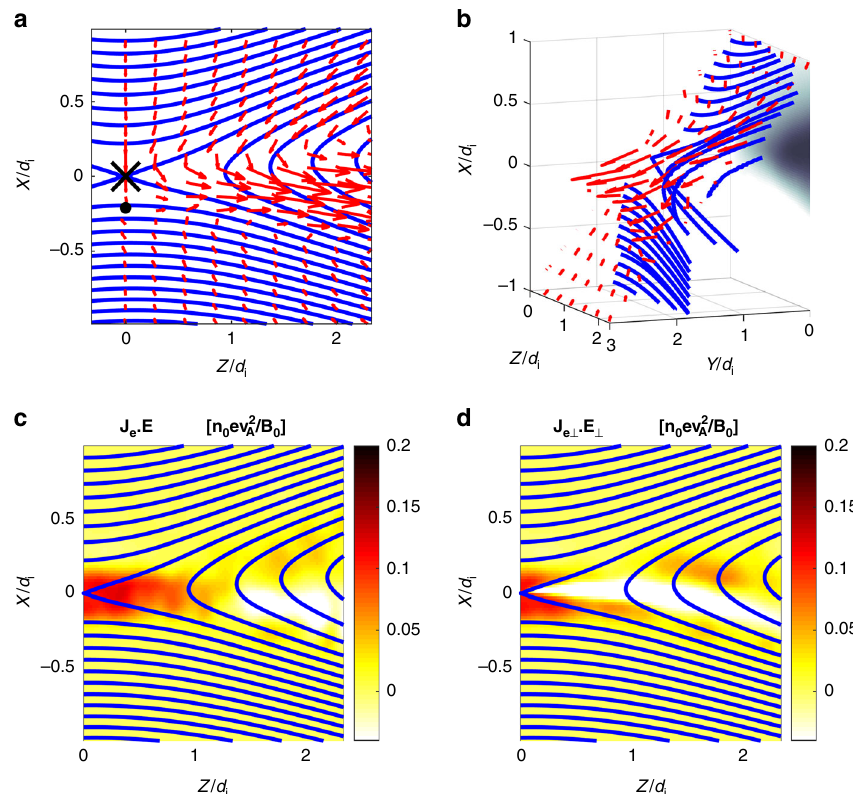
Fig. 6 Electron dynamics calculated by our 2D numerical simulation. The presentation format is the same as Fig. 2 data from MRX. a Electron fl ow vectors are plotted together with reconnecting fi eld lines. The X marks the X-line and the black circle denotes the stagnation point of in-plane electron fl ow. b 3D views of electron fl ow vectors with respect to the reconnecting fi eld lines. Because of the dipole structure of out-of-plane magnetic fi eld, the reconnection plane is tilted in the Y -axis. in the high-density (upper) side. Note that strong electron current in Y -direction at the stagnation point. c Energy deposition to electrons through j e · E is concentrated in the electron diffusion region around the stagnation point. d Perpendicular component, j e ⊥ ∙ E ⊥ is much larger than j E ∙ E e|| || and concentrated in the electron stagnation point, while contribution of j e|| || is notable at the exhaust as seen in c and d . Some of the minor differences from Fig. 2 should come from the difference of boundary condition set up in the